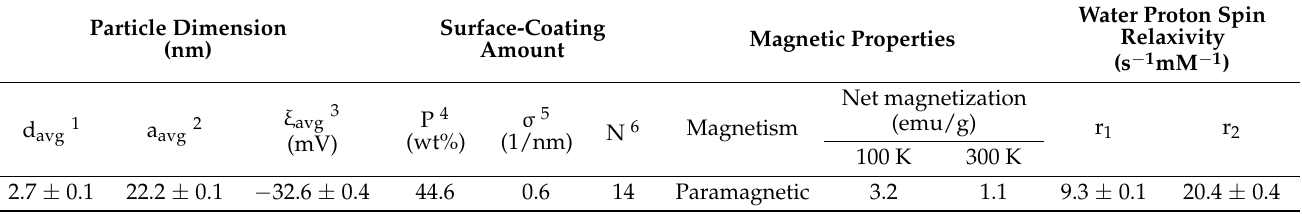
Figure 2. ( a-i ) High-resolution transmission electron microscope (HRTEM) image (arrows indicate FA-PAA-coated MnO nanoparticles) and ( a-ii ) a magnified image of a nanoparticle indicated as a dotted circle in ( a-i ). ( b ) Particle diameter distribution. ( c ) Hydrodynamic diameter distribution. Table 1. Summarized properties of the FA-PAA-coated MnO